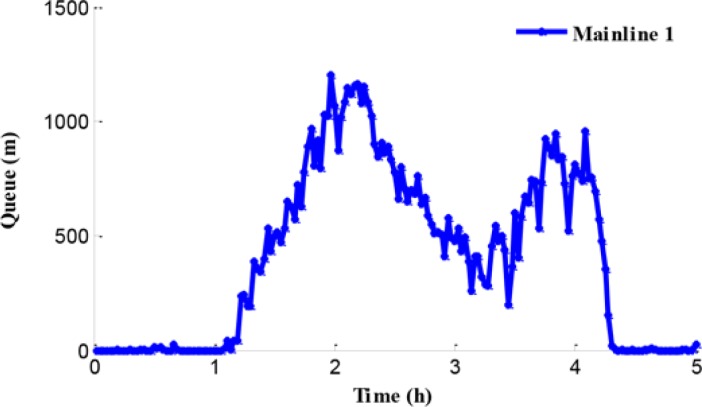
Queue in mainline 1.